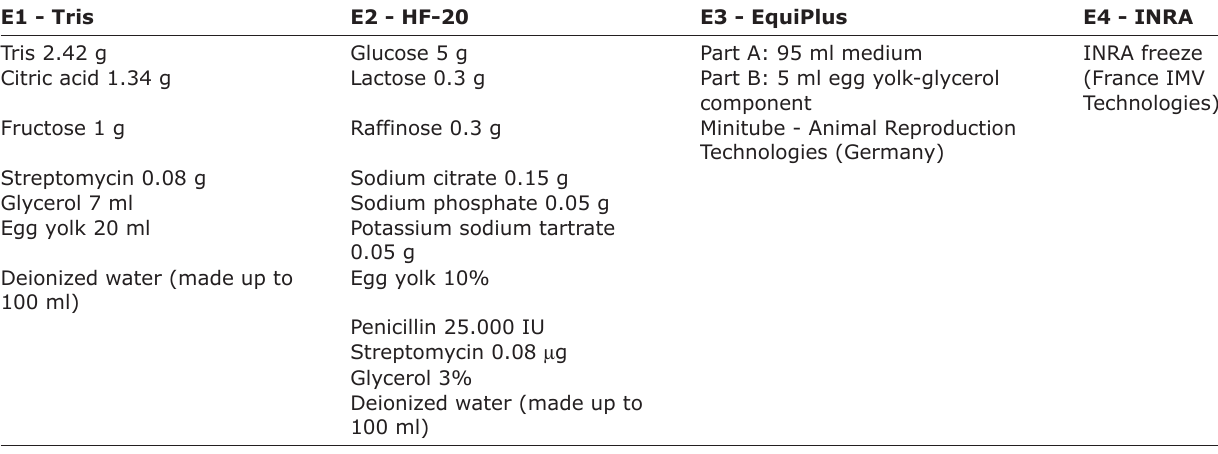
Table-1: Semen extenders used on each